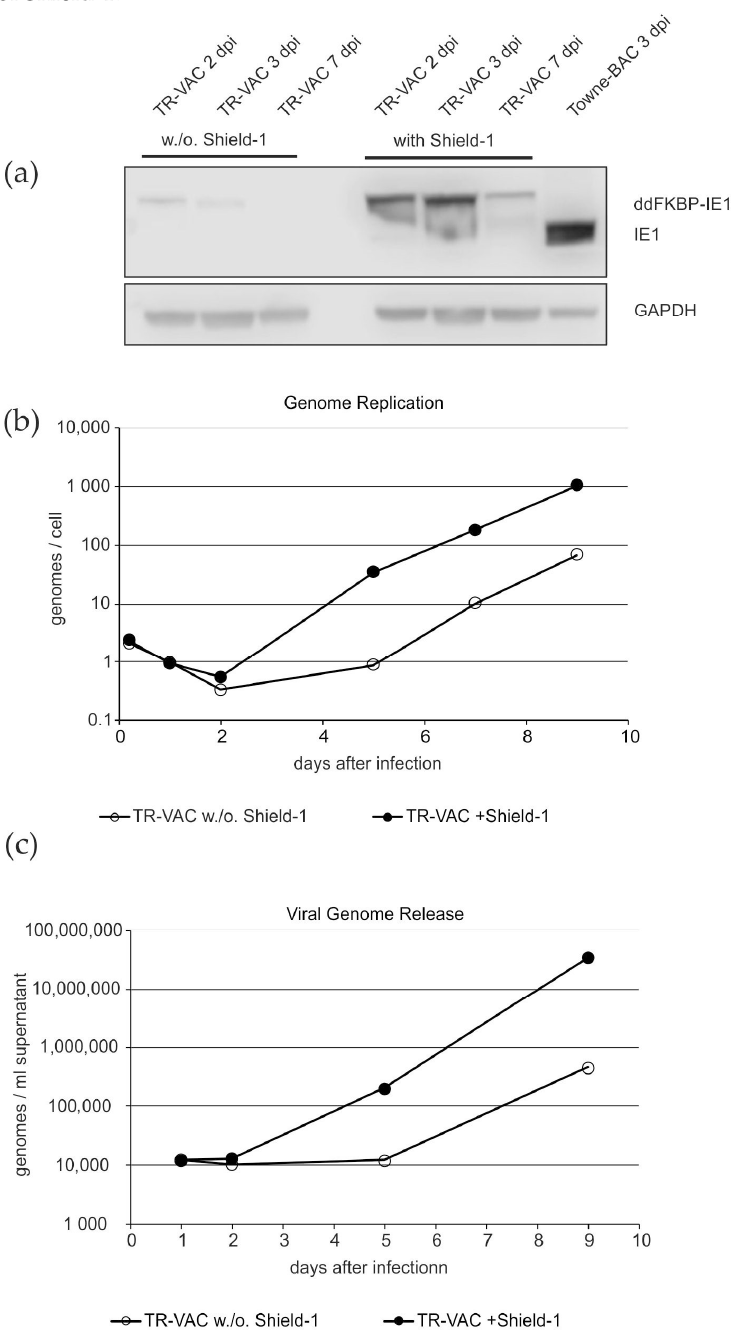
Figure 2. Analysis of ddFKBP-IE1 protein expression and genome replication in, and genome release from TR-VAC infected HFF. ( a ) Immunoblot analysis of lysates of HFF, infected for the indicated incubation periods with TR-VAC or with the parental strain Towne-BAC (control). Shield-1 was either added or omitted. The levels of GAPDH were measured from the same samples as loading controls. ( b ) Quantitative PCR analysis of the viral genome replication in HFF, infected with TR- VAC and cultured with or without Shield-1. Lysates for analysis were collected at the indicated dpi. ( c ) Quantitative PCR analysis of the viral genome release from HFF, infected with TR-VAC and cultured with or without Shield-1. Cell culture supernatants for analysis were collected at the indicated